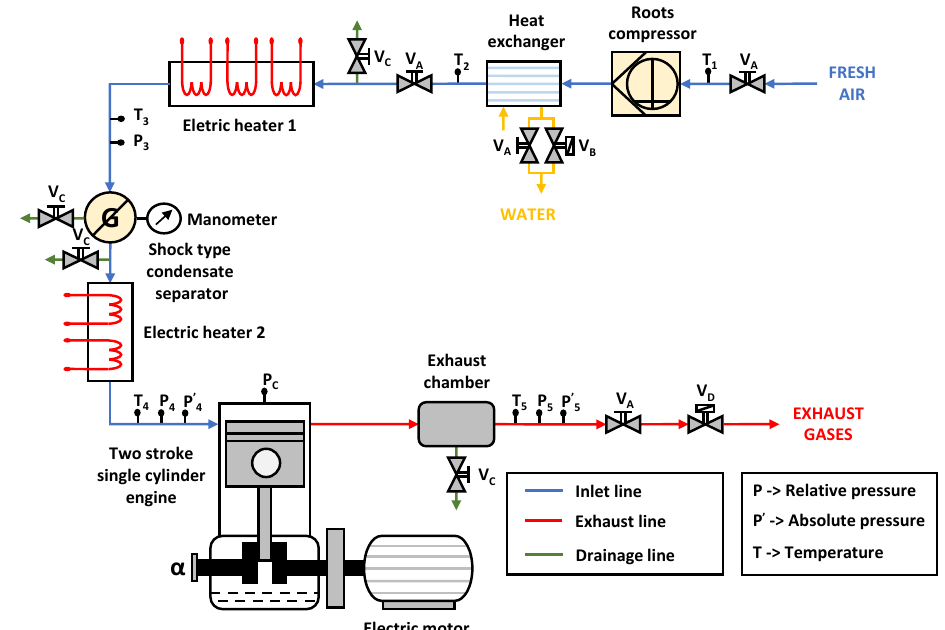
Figure 2. Scheme of the main gas circuit under a reactive atmosphere